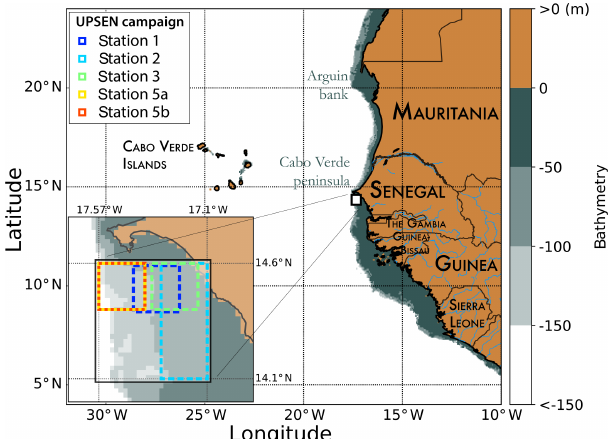
Figure 1. Mauritania and Senegal coastal topography. The land is in brown, and the ocean depth is represented in meters by the color scale on the right side of the figure. The UPSEN stations are shown at the bottom left of the